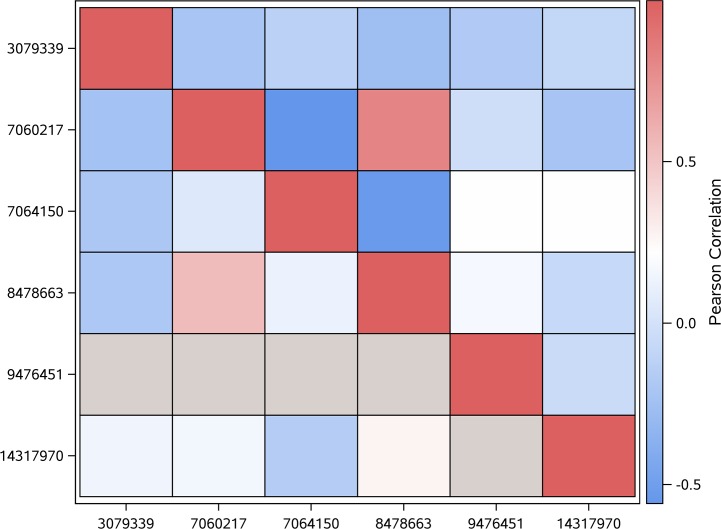
Heat map depicting the linear correlation between genotypes across the variants associated with scouting behavior located on LG2 (NC_007071.3); location in bp is denoted by the rightmost number and gray color indicates no genotypic variation among all bees within one behavior group.